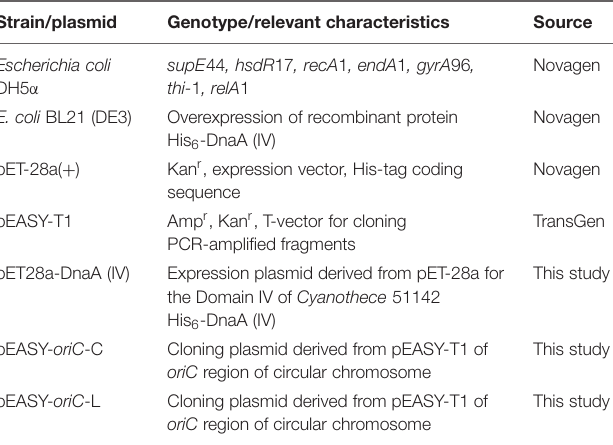
TABLE 1 | Bacterial strains and plasmids used in this study. TABLE 2 | Oligonucleotides used in this study.